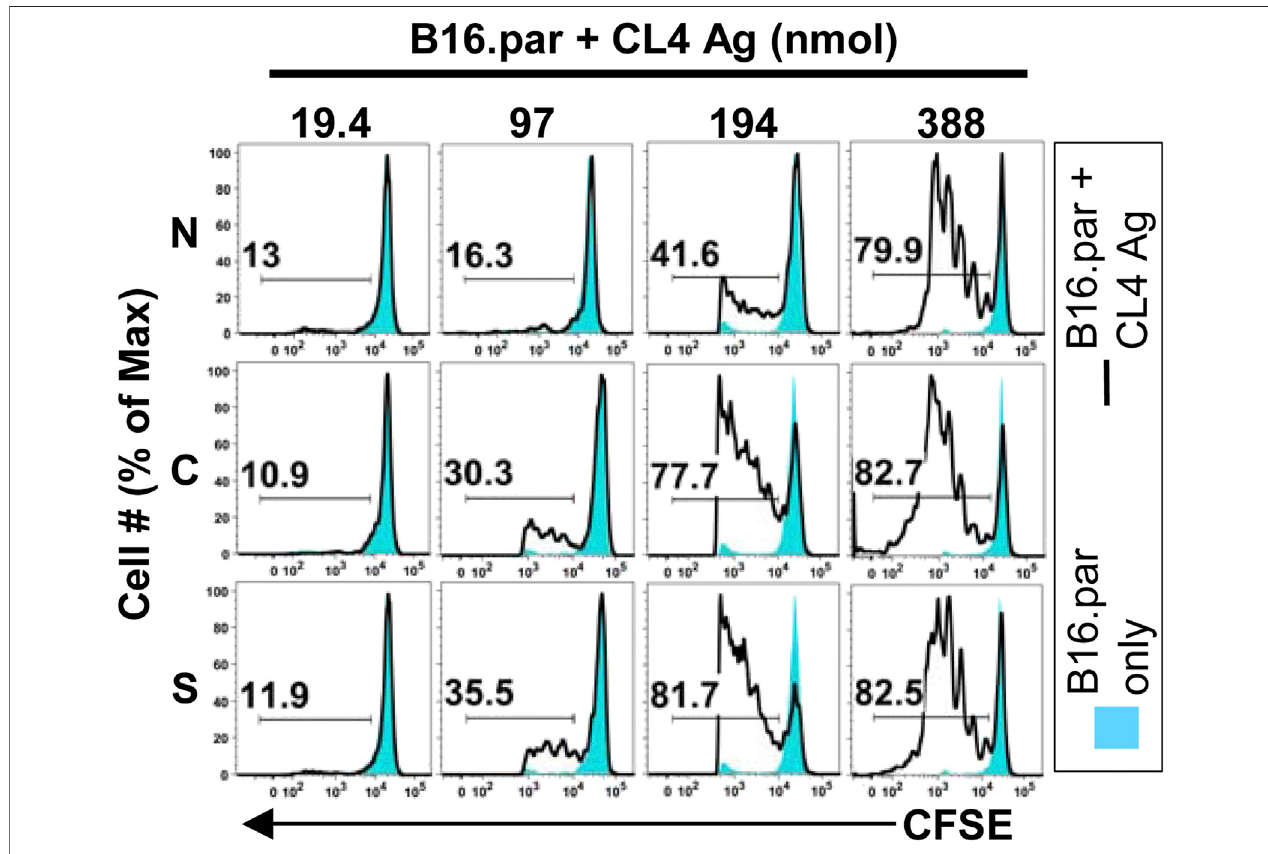
FIGURE2| Crosspresentationissensitivetolowantigenloads.Crosspresentationwasassessedusingthe invivo Lyons-Parishassay(LyonsandParish,1994),in which carboxy fl uorescein succinimidyl ester (CFSE) stained neoantigen speci fi c T cells (CL4) were intravenously injected into F1 mice bearing the melanoma tumour (B16.par)bearingtotalsof19.4,97,194or388 nmoloftheneoantigenCL4ineitherthenucleus(N),cytoplasm(C)orsupernatant(S).ProliferationofTcellsinthetumor draining lymph node on day 11 is shown by the number and size of peaks to the left of the parental non-proliferating single blue peak. Figure originally published in Anyaegbu et al., 2014. PLOS One 9: